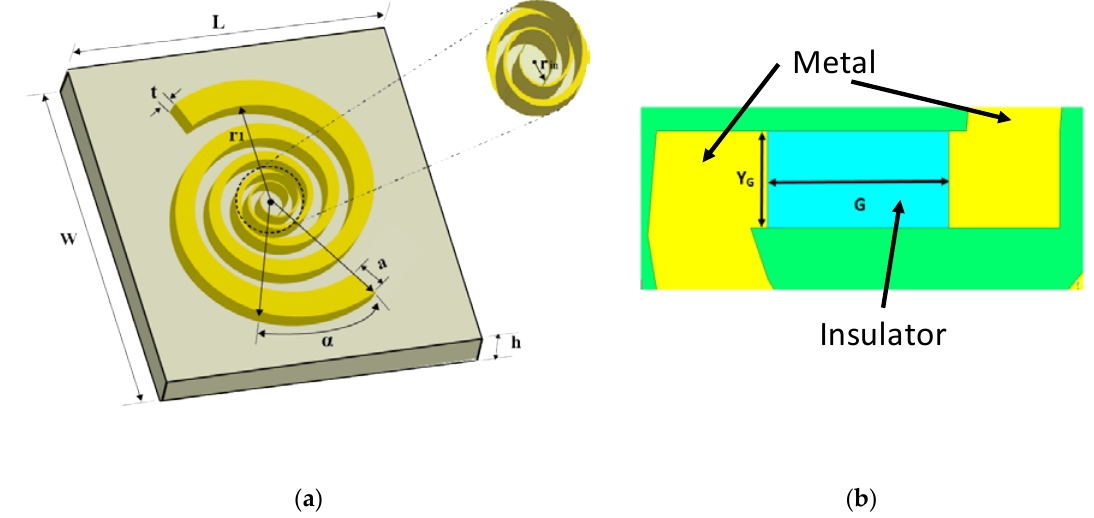
Figure 2. Schematic of the designed rectenna. ( a ) Designed log-spiral nano IR antenna; r 1 : inner radius of the spiral, α: increment angle, a : growth rate, t : thickness of the conductor (gold) material, L : length of the substrate, W : width of the substrate, and h : thickness of the substrate; and ( b ) designed horizontal metal insulator metal (MIM) diode configuration .